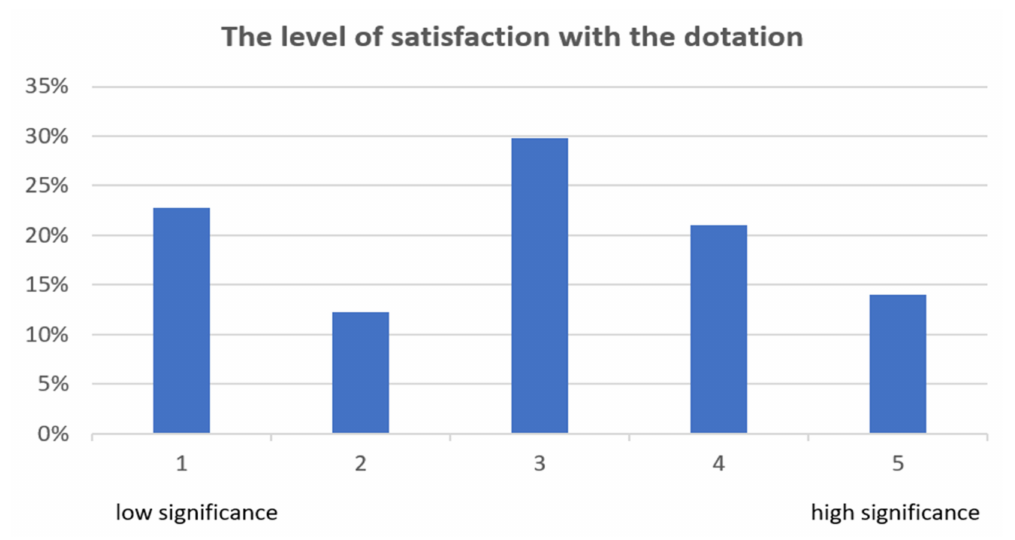
Figure 7. Satisfaction with the subsidy level ( n = 57). Source: own study.